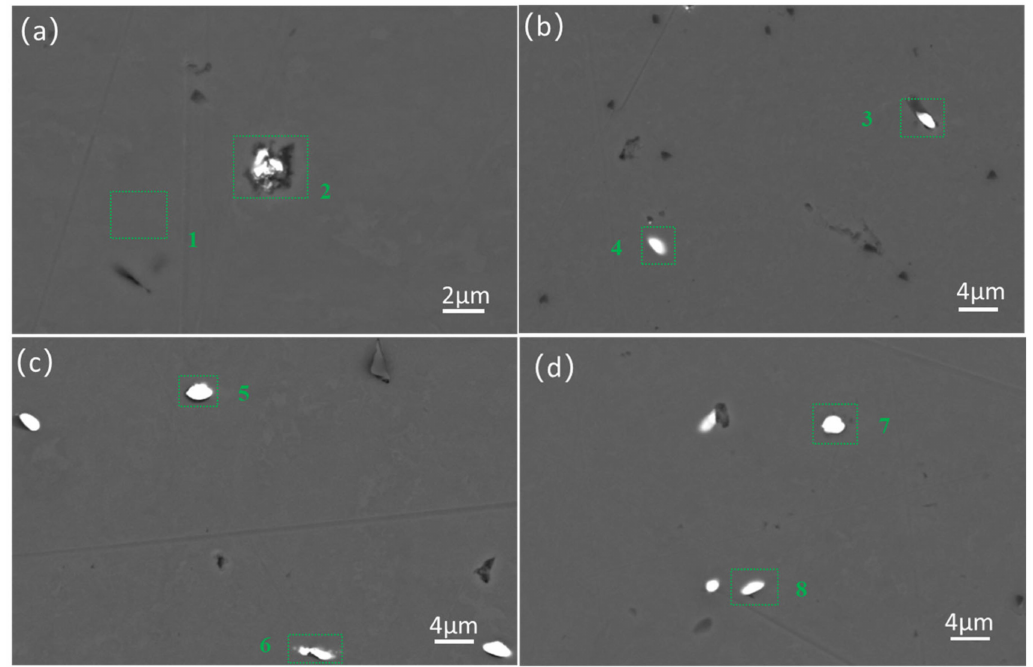
Figure 4. The SEM images of the precipitated phases of the Al-Mg-Sn-Ga-xBi alloys. ( a ) x = 0,